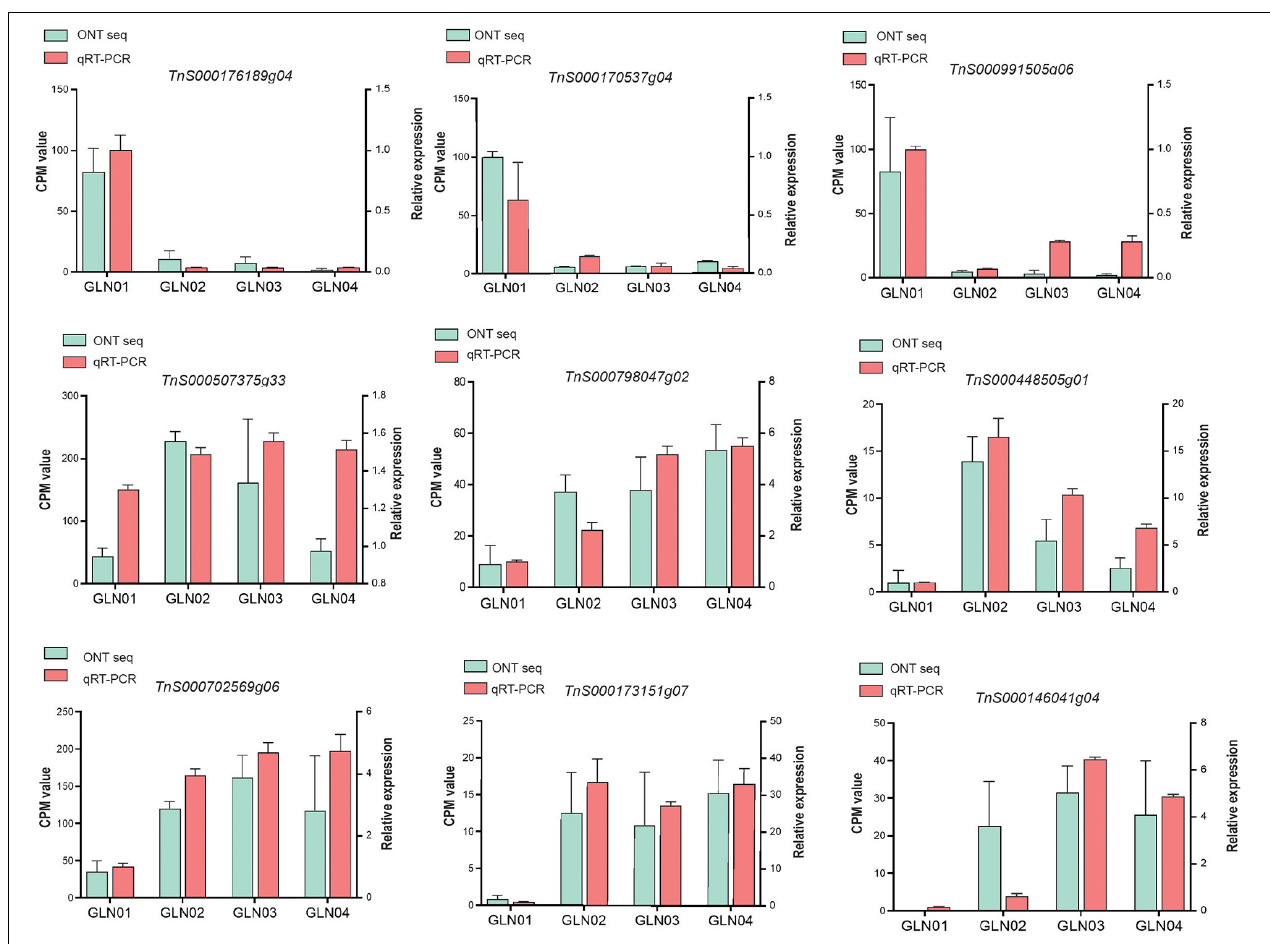
FIGURE 6 | qRT-PCR was used to verify the expression patterns of nine selected genes, using ACTIN as an internal control. Counts per million (CPM) values from Nanopore sequencing are indicated on the left y -axis and relative qRT-PCR expression levels are indicated on the right y